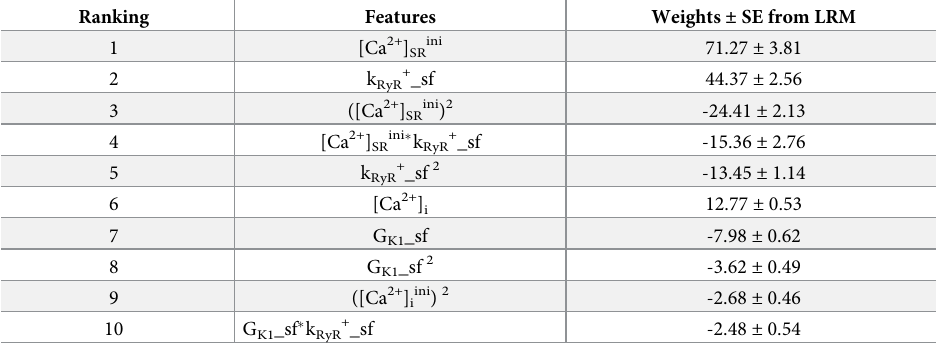
Table 1. Ectopic beat features ranked by relative importance.